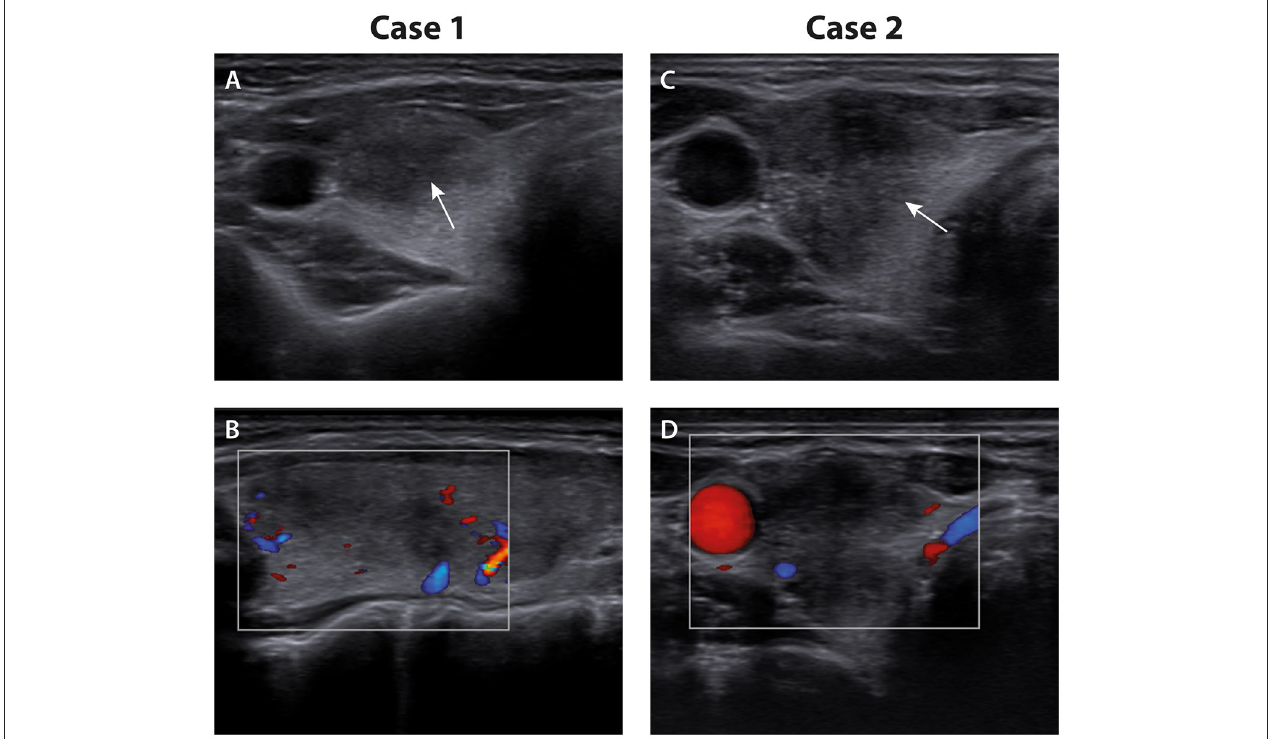
FIGURE 1 | Thyroid ultrasound. (A) Case 1: transverse view of the right thyroid lobe with an ill-defined hypoechoic area (arrow). (B) Case 1: longitudinal view of the right thyroid lobe with decreased blood flow within the hypoechoic areas on color-coded Doppler sonography. (C) Case 2: transverse view of the right thyroid lobe with a distinct hypoechoic area (arrow). (D) Case 2: transverse view of the right thyroid lobe with decreased blood flow within the hypoechoic area on color-coded Doppler